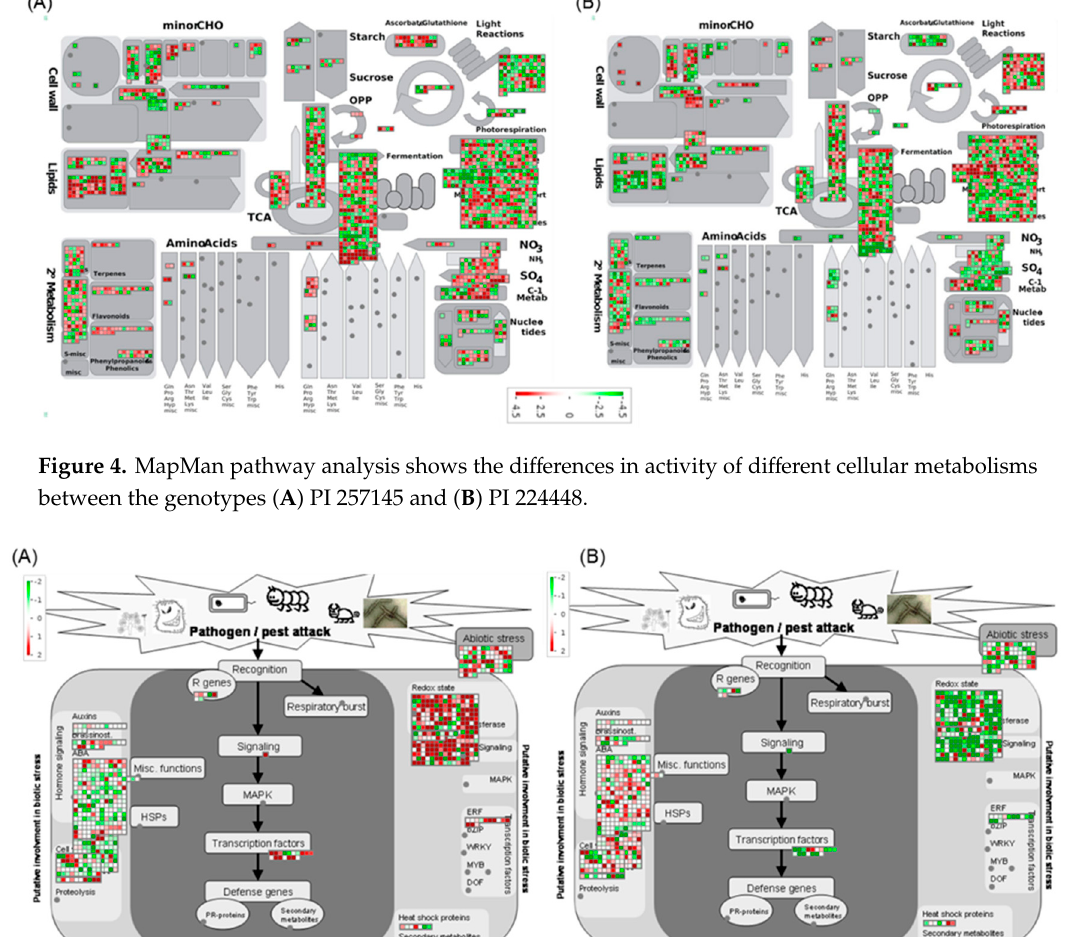
Figure 3. Top 20 enriched KEGG pathways among upregulated ( A ) and downregulated ( B ) DEGs in PI 257145 versus PI 224448. Rich factor is the ratio of the number of DEGs to the total gene number in a pathway. Here, q-value is a corrected p -value. The color and size of the dots represent the range of q-value and the number of DEGs mapped to the indicated pathways, respectively.